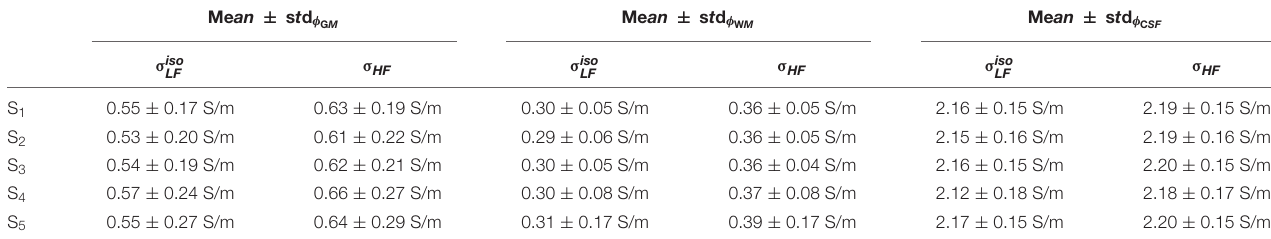
FIGURE 7 | φ GM , φ WM and φ CSF distributions for subjects S2 to S5. and std φ in GM, WM and CSF, at LF (left) and HF (right) in all TABLE 1 | Mean φ k k